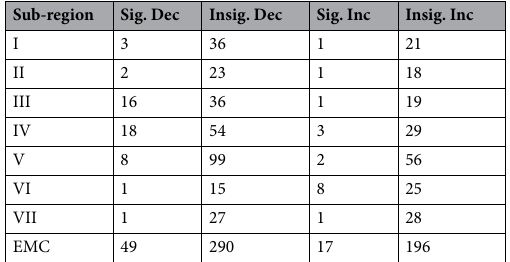
Table 2. Number of the sites with different trends (tested by the MMK method) for the annual ET o series over the period 1961–2013 in different sub-regions of China. Sig. Dec-significant decrease, Insig. Dec-insignificant decrease, Sig. Inc-significant increase, Insig. Inc-insignificant